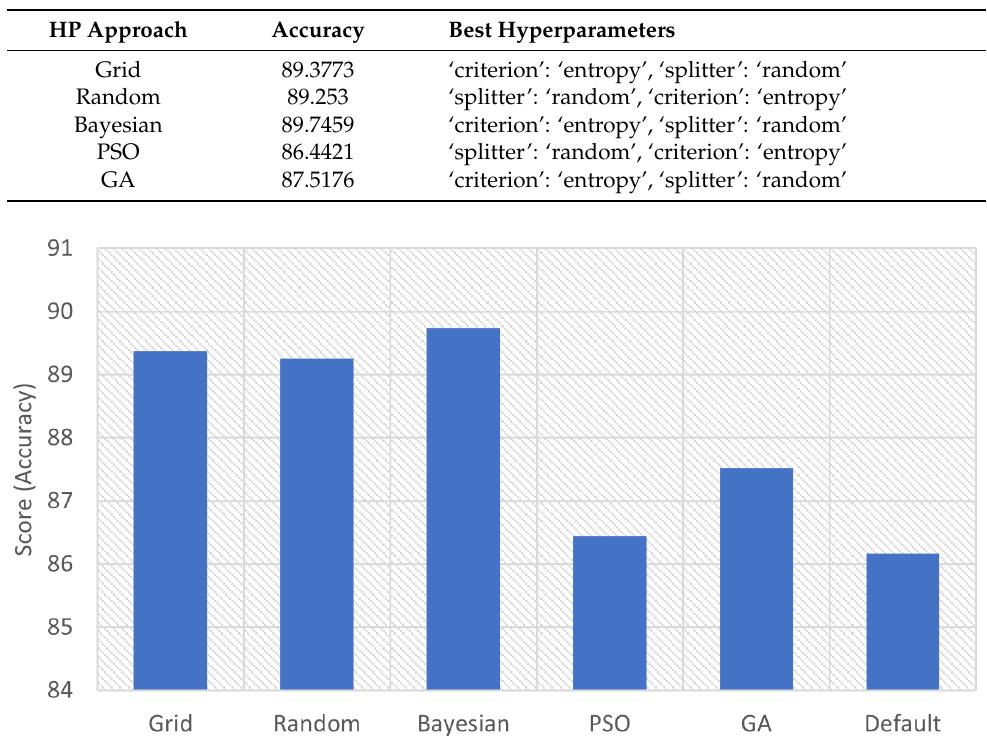
Figure 10. Score per parameter for Ridge Classifier (RC). Table 3. Hyperparameter tuning for Decision Tree.